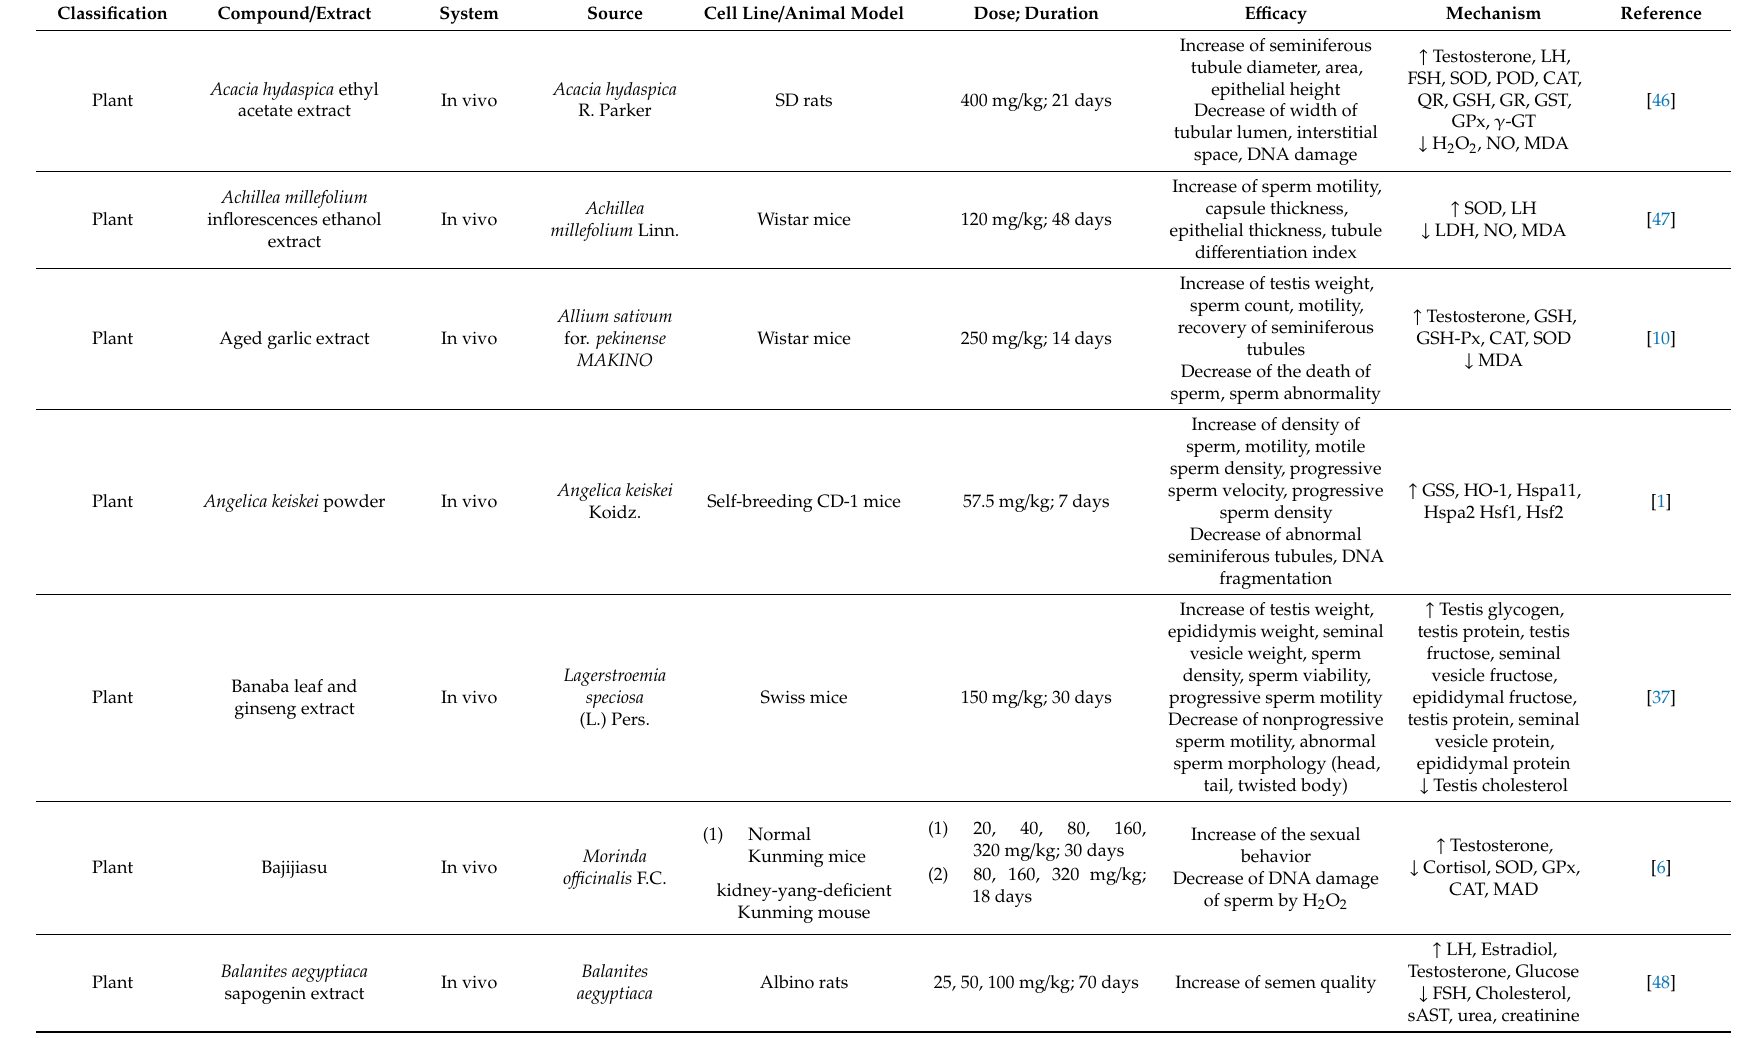
Table 2. Plant derived natural products and male infertility (in vivo